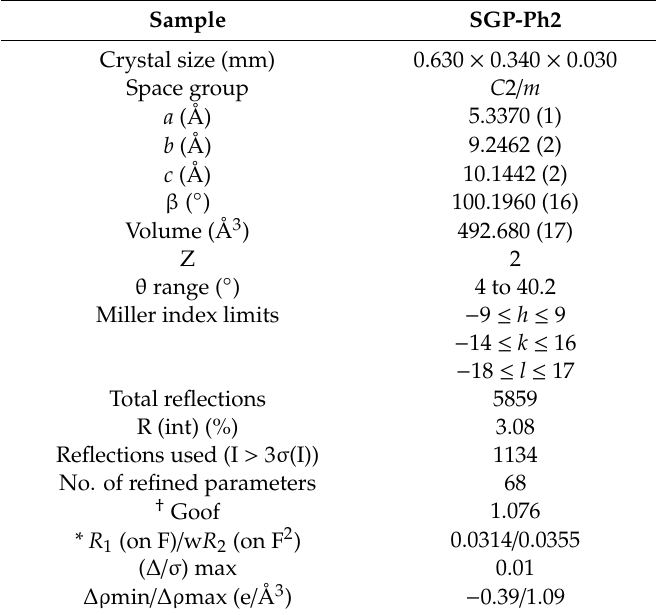
Table 5. Crystal, experimental and refinement